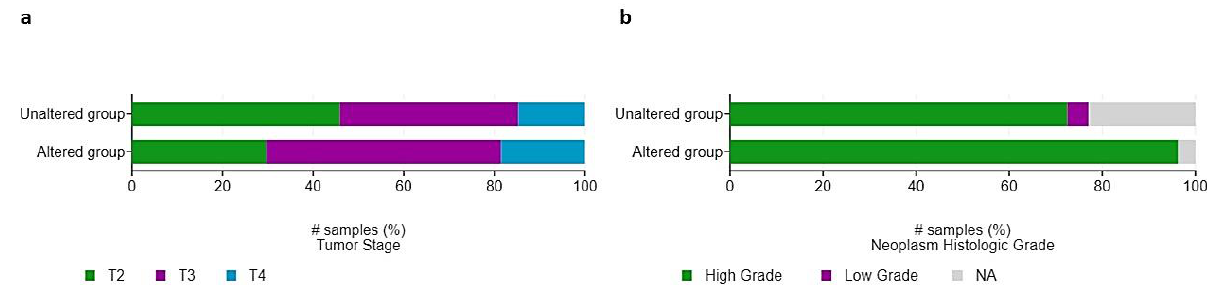
Figure 6. Dot plot graphs of ( a ) mutation count and ( b ) total mutational burden (TMB) of HIF-2- altered and unaltered tumors. ( c ) Bar graph of lymph node status of HIF-2-altered and unaltered tumors. # Number of samples (%).